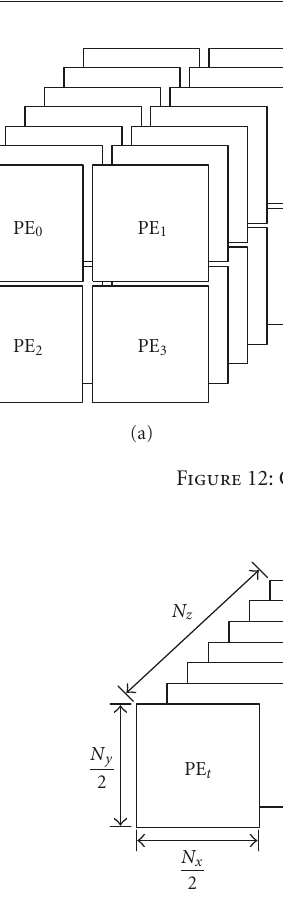
Figure 13: Illustration of cube